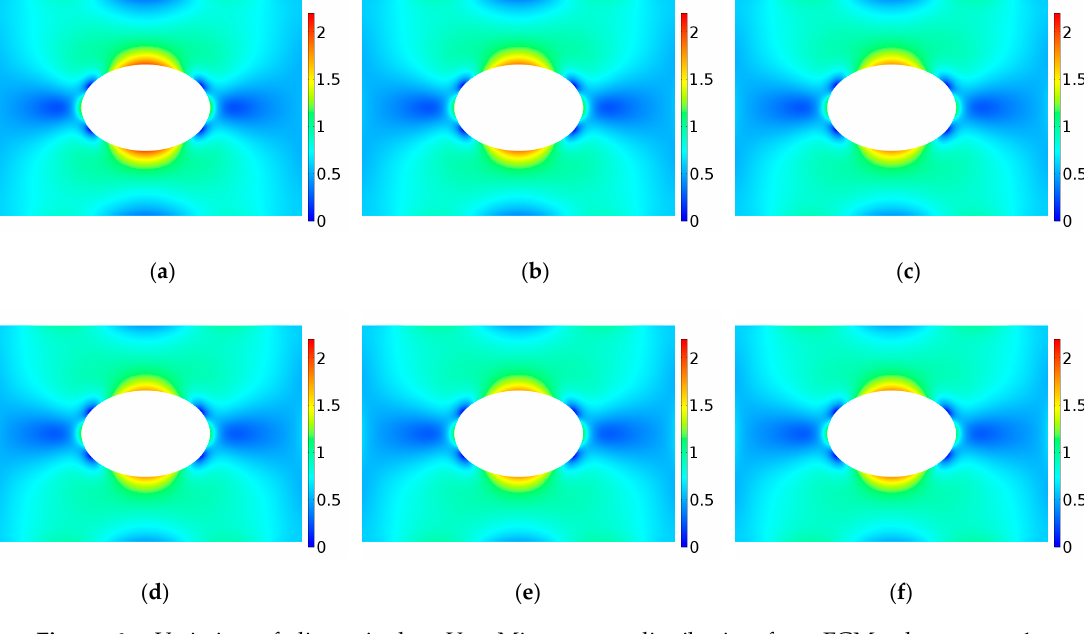
Figure 5. Variation of stress concentration factor K for power-law inhomogeneous variation when c > 0. ( a ) variation of Young modulus; ( b ) results for r-FGM; ( c ) results for x-FGM; ( d ) results for y-FGM.